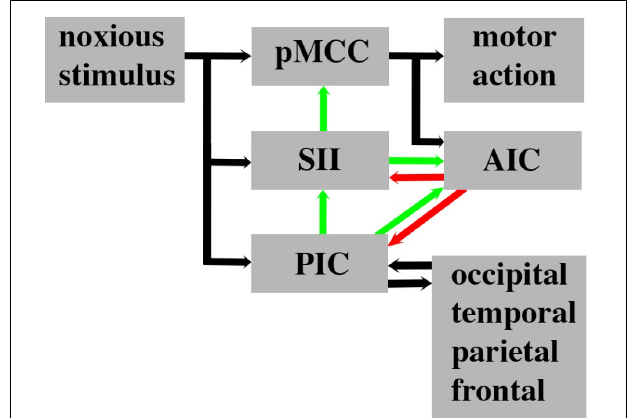
FIGURE 6 | Human cortical circuitry consistent with the parallel forward models algorithm as presented in Figure 4 . Parallel streams of noxious sensory input enter the posterior middle cingulate cortex (pMCC), secondary somatosensory area (SII), and posterior insula cortex. The SII and PIC contain internal models of pMCC and SII respectively. The outputs of these models are predictions (green arrows) and they are relayed to a comparator module in the anterior insular cortex (AIC). The AIC compares the output of pMCC and SII and the error (red arrow) is fed back to the SII to adjust its internal model of pMCC. The prediction of SII is fed back to the pMCC where it is used to refine its response to the noxious stimulus. The prediction of the internal model in PIC is fed forward to the AIC where it is compared with the prediction of SII. The error is then relayed back to the PIC to fine tune its internal model of SII. The prediction of the PIC is also fed back to the SII to refine its prediction. The internal model in the PIC is also adjusted in response to widespread feedback from across the cortex and the PIC has reciprocal connections with these regions that contribute to the feeling of